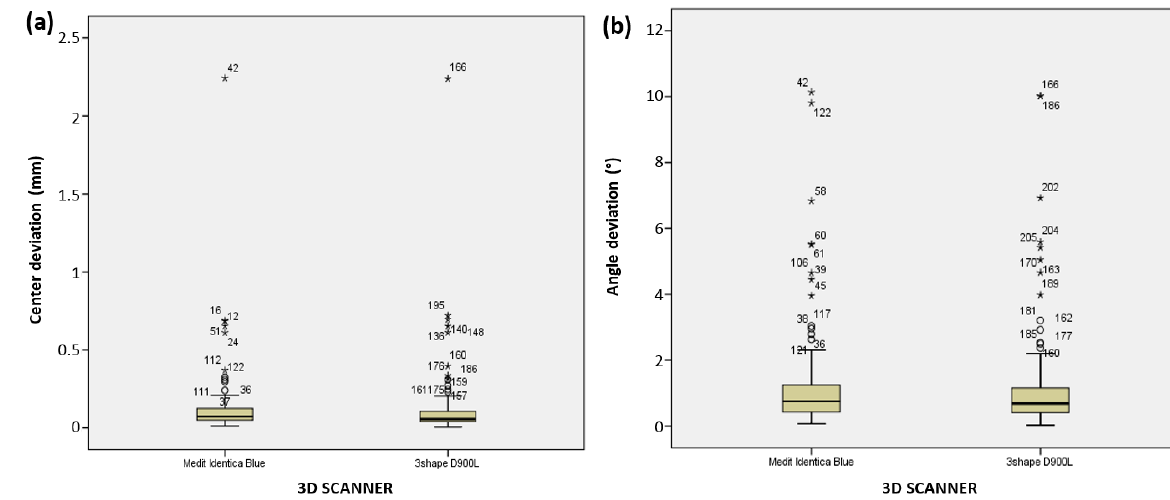
Figure 14. Graphic display of the analysis results depicting the deviation from ( a ) the center and ( b ) the angle of implant deviation for both 3D scanners.